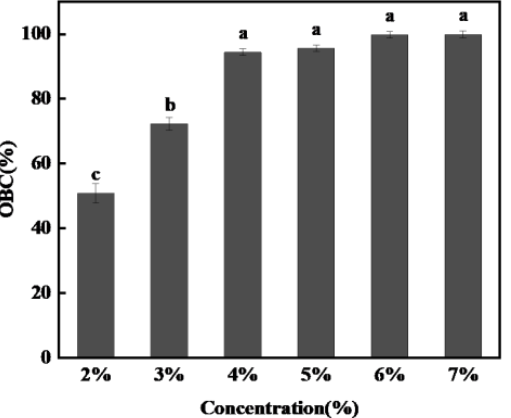
Figure 3. Effect of stigmasterol concentration on the oil binding capacity of the stigmasterol organogels. (Means with different letters in the same classification significantly differ at p < 0.05). The self-assembled structure of stigmasterol may reach its saturation point [34] at